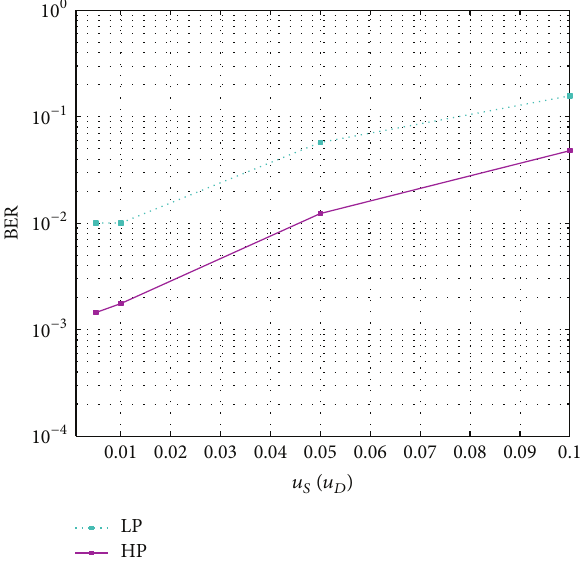
Figure 9: BER for increasing values of the average spread of scatterers around the source and destination.